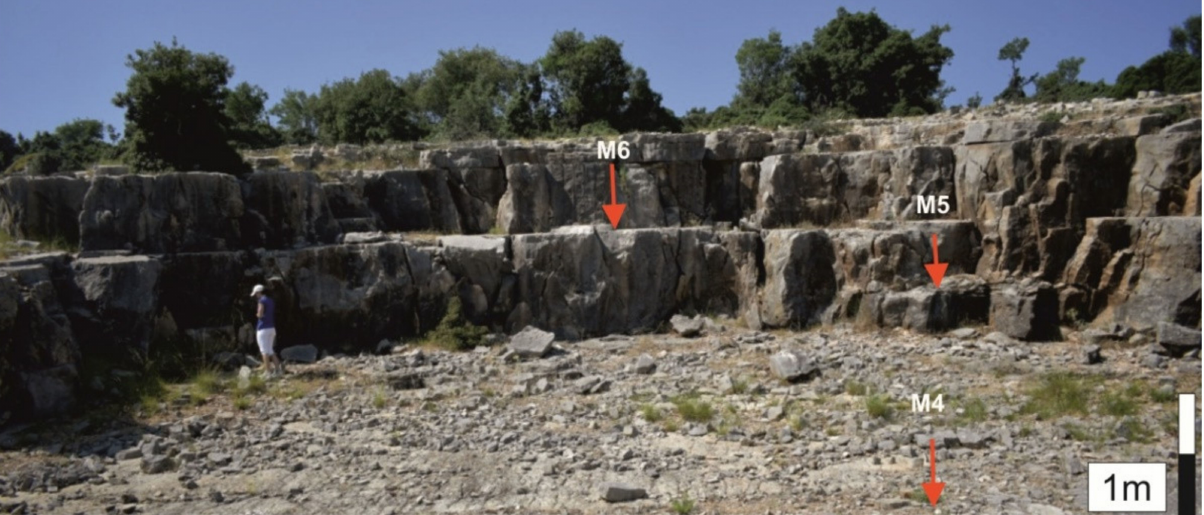
Figure 24. Part of the Eocene (Lutecian) carbonate